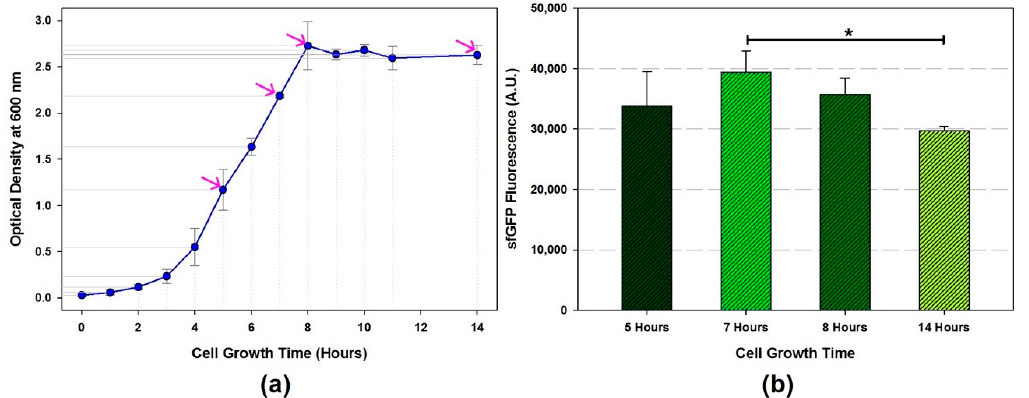
Figure 2. Cell extract performance upon the different cell harvest time. ( a ) The E. coli K12 MG1655 Δ prfA Δ endA Δ rne growth curve. The cell collected at 5, 7, 8, 14 h from the beginning of cell culture. The pink arrows indicate each harvest time. ( b ) The intensity of the cell-free synthesized sfGFP fluorescence from each cell extract (1750 Joules of sonication energy input, 1000 μ L of processing volume, and 60 min of runoff reaction time). Data are presented as the average ± standard deviation ( n = 3); * p < 0.05 according to one-way analysis of variance (ANOVA).